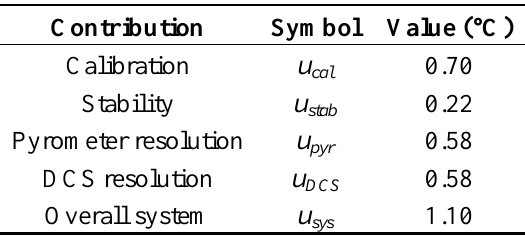
Table 4. System uncertainty contributions.